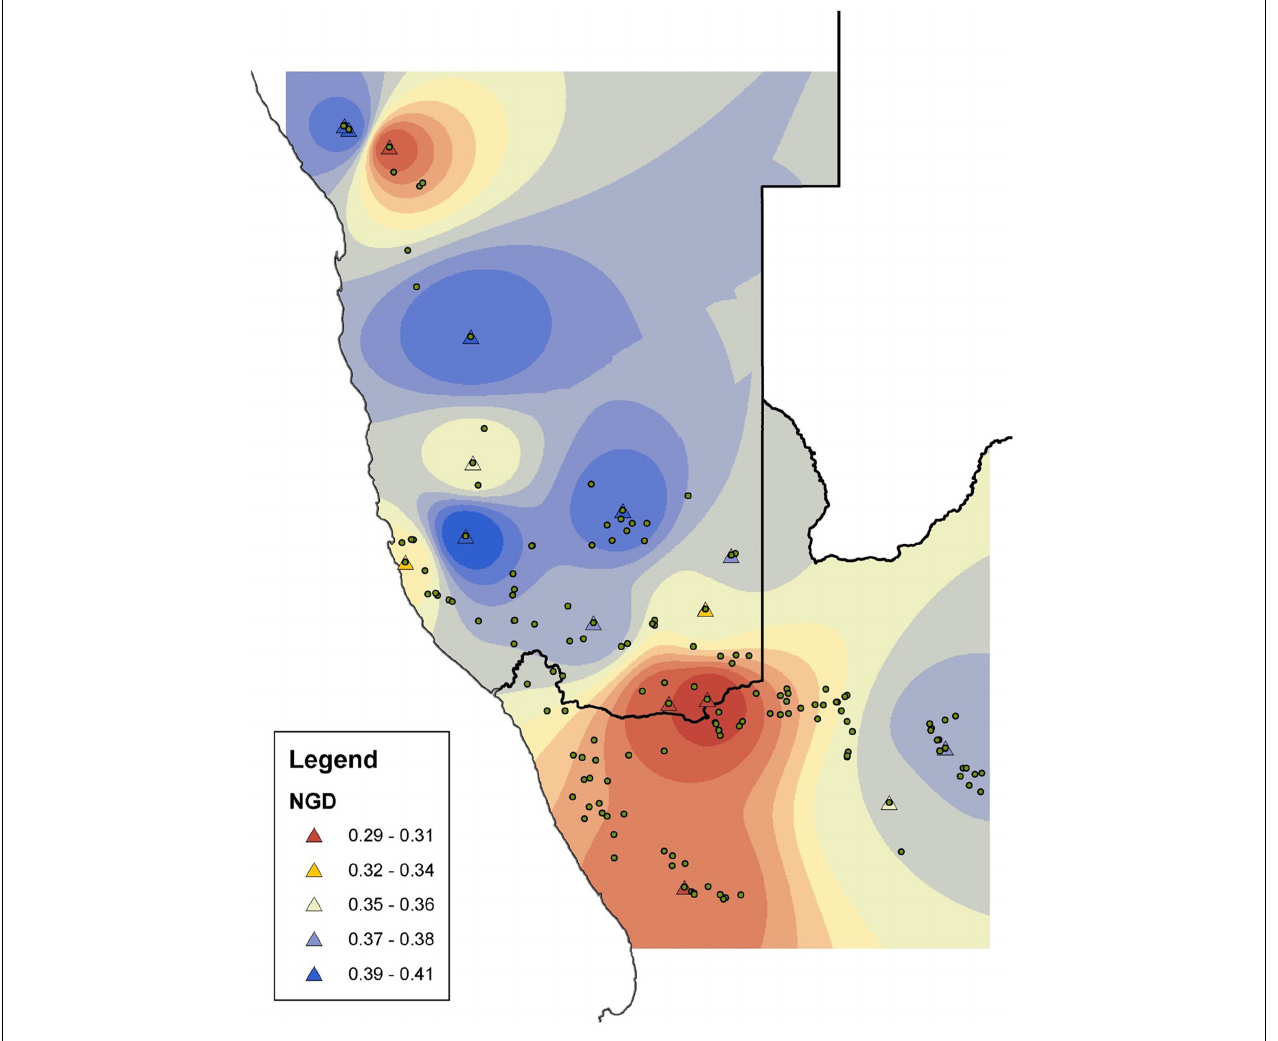
FIGURE 3 | The distribution of genetic variation in Aloidendron dichotomum based on Nei’s gene diversity h (NGD) calculated from amplified fragment length polymorphisms (AFLPs). Triangles represent genetic sampling locations; circles represent known populations surveyed in Foden et al.